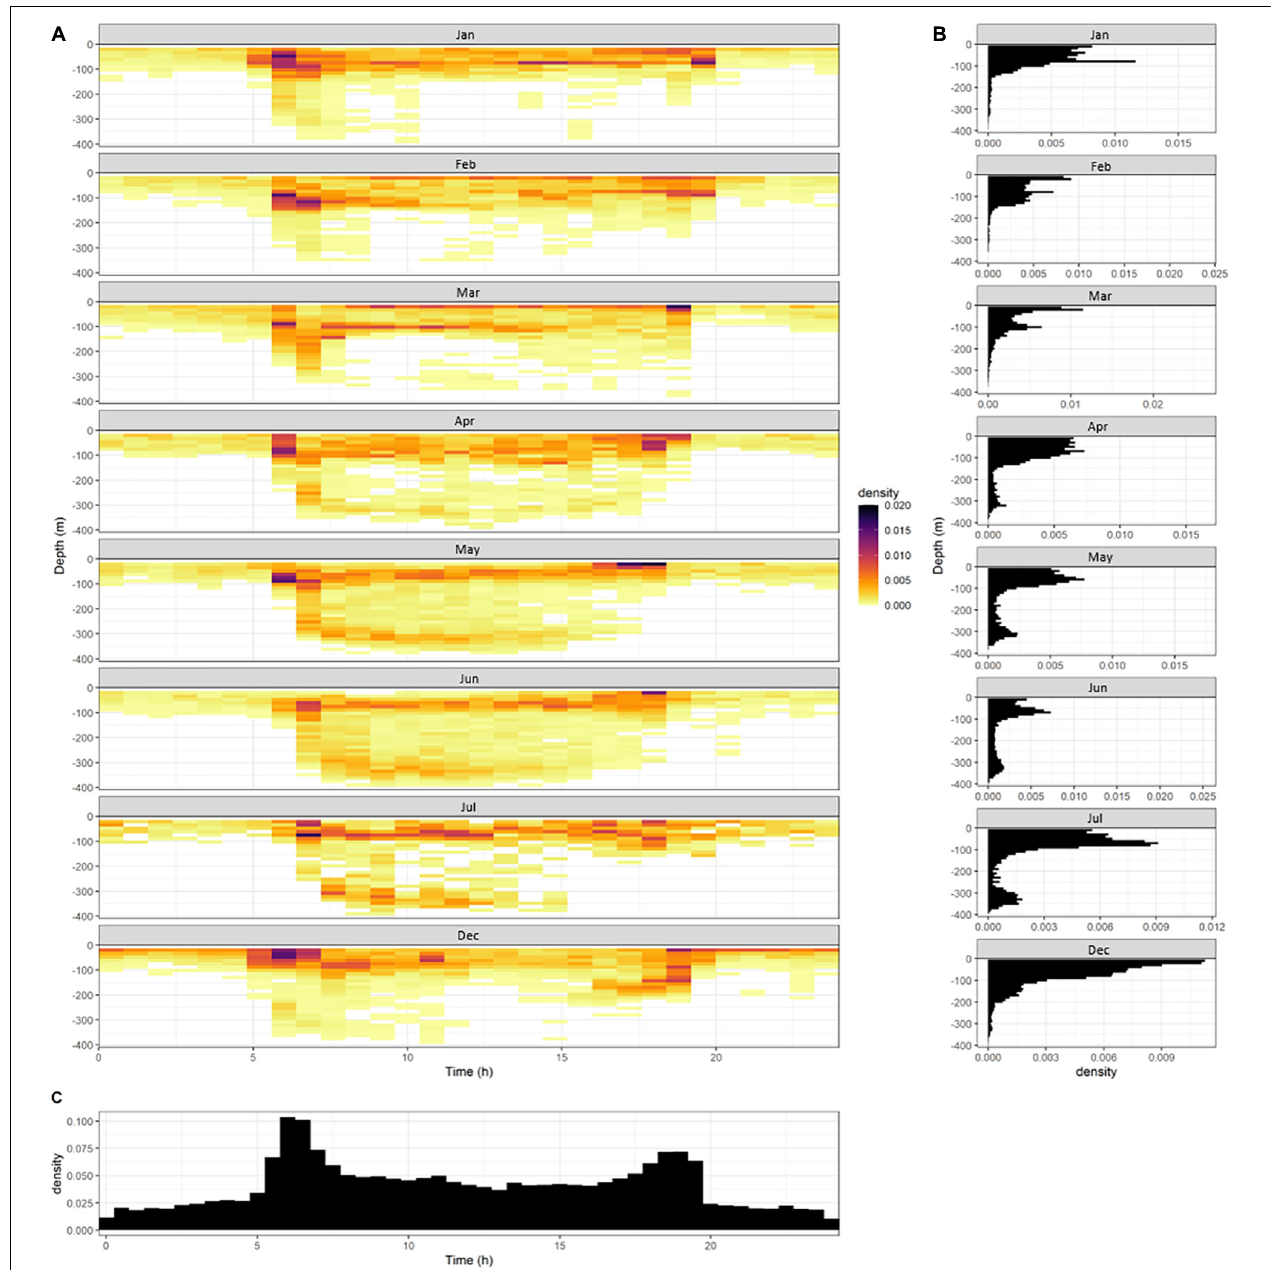
FIGURE 4 | (A) Density plot showing the time of day and the depth at which fast starts occurred by month. Noting that no accelerometer tagged tuna were at liberty between August and November. (B) Frequency of fast start events by depth, and (C) frequency of fast start events by time of